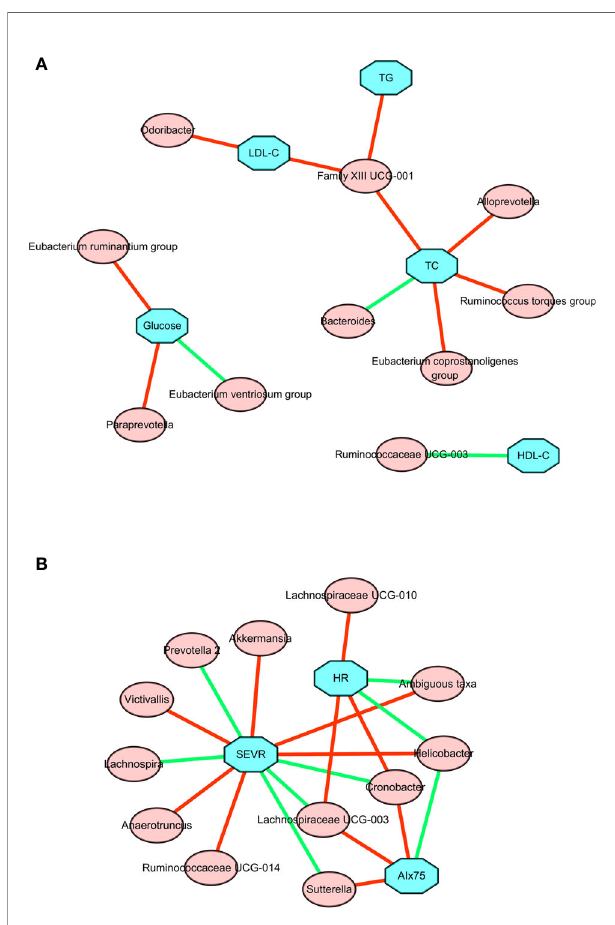
FIGURE 4 | Correlation network between changes in gut microbiota members and clinical parameters after a 6-week combined exercise and diet intervention. (A) Correlations between changes in gut microbiota members and metabolic parameters. (B) Correlations between changes in gut microbiota members and central hemodynamics. The blue square represents clinical parameters, the red circle represents gut microbiota; the red line represents the positive correlation coef fi cient, and the green line represents the negative correlation coef fi